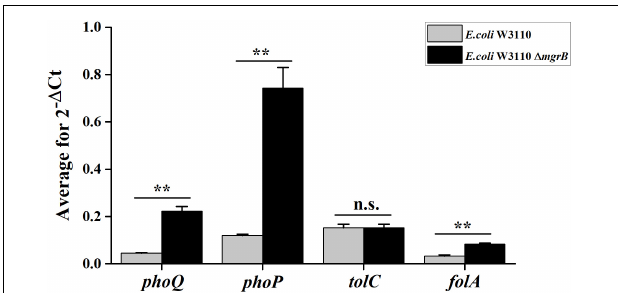
FIGURE 1 | Average transcription levels of the genes phoP , phoQ , folA , and tolC in E. coli W3110 (wild type) and E. coli W3110 (cid:49) mgrB , as measured with qRT-PCR. Expression levels of gapA were normalized as an endogenous control. Data represent mean ± SD from three independent experiments. P values were calculated using t tests (* P < 0.05; ** P < 0.01; *** P <